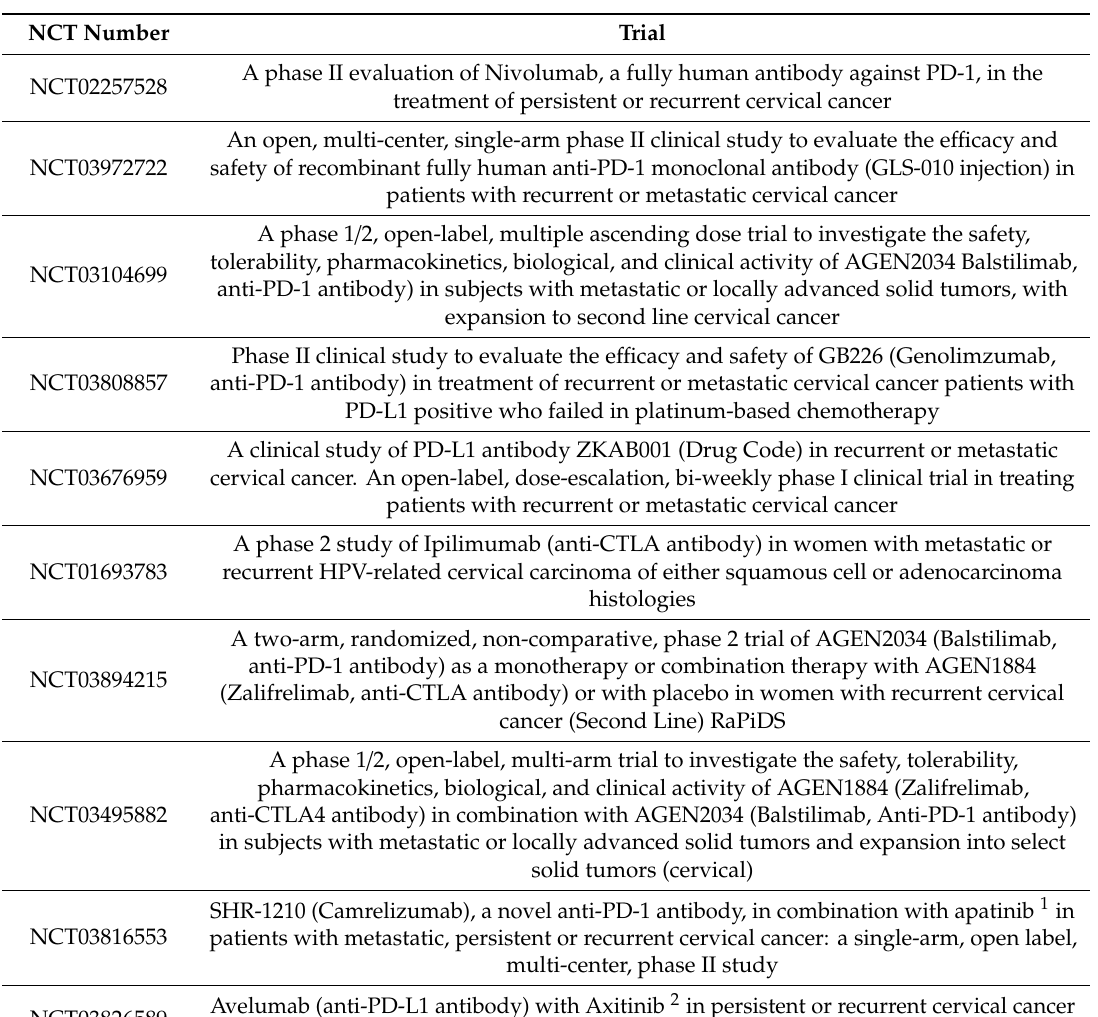
Table 4. Ongoing trials with immune checkpoint inhibitors in metastatic, recurrent, or persistent carcinoma of the uterine